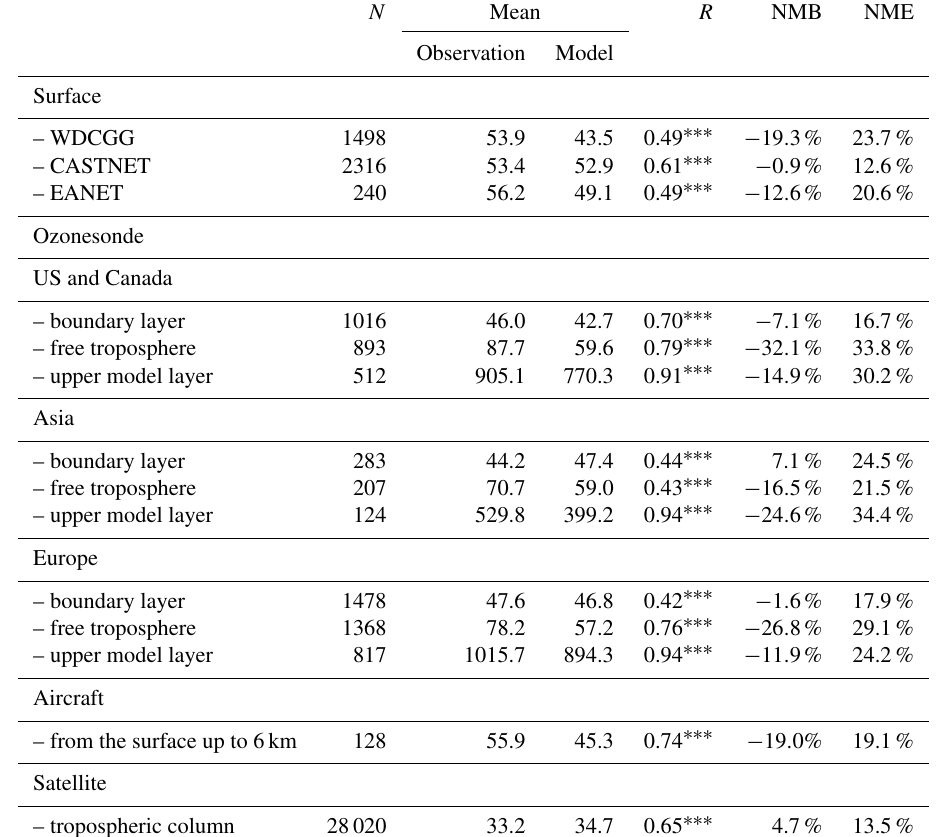
Table 3. Statistical analysis of modeled O 3 concentration using surface, ozonesonde, aircraft, and satellite observations. N Mean R